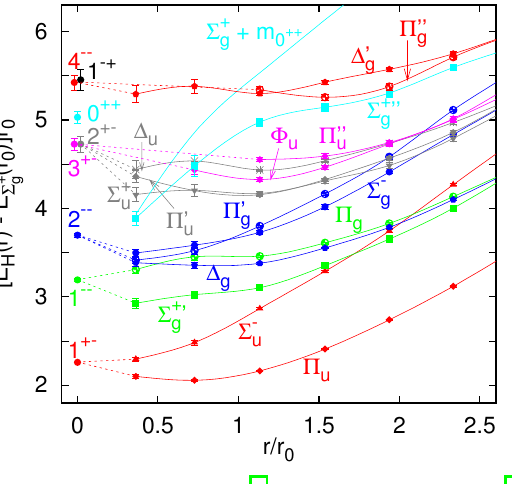
Figure 1. The lowest hybrid static energies [4] and gluelump masses [17] in units of r 0 ≈ 0 . 5 fm. The absolute values have been (cid:28)xed such that the ground state Σ + g static energy (not displayed) is zero at r 0